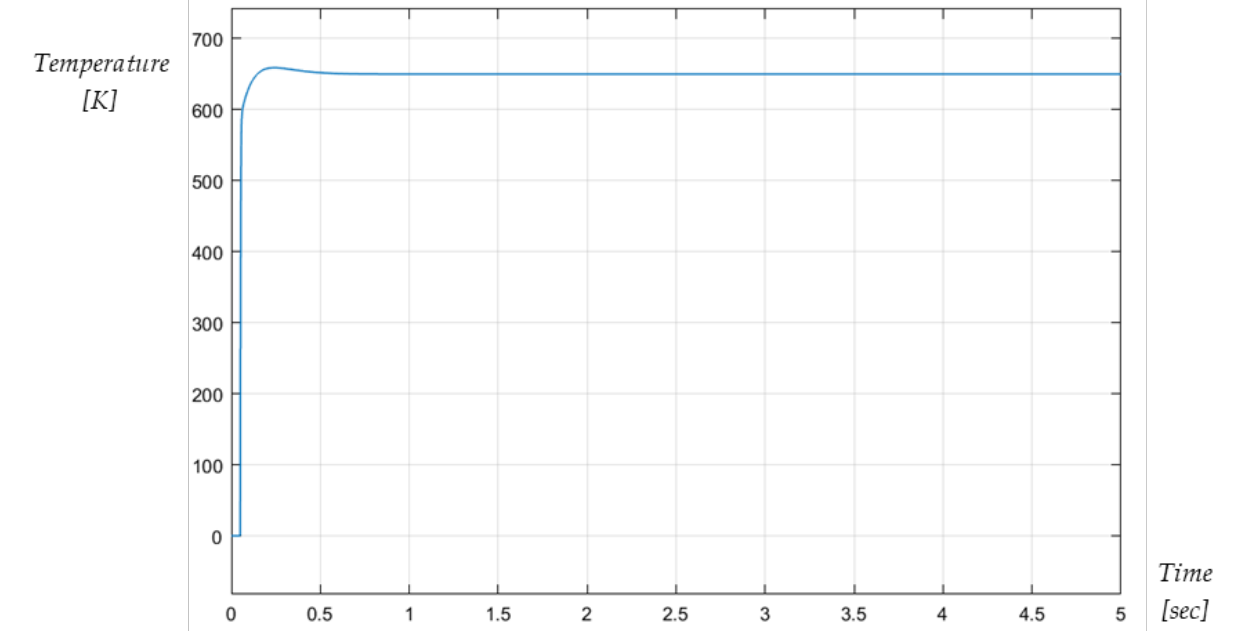
Figure 8. PID controller applied in a thermal manufacturing process: tracking efficiency.